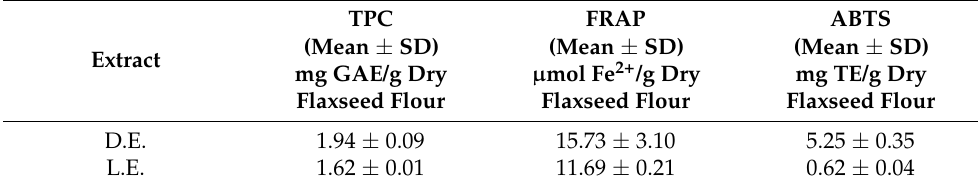
Table 2. Total phenolic content and antioxidant activity for D.E. and L.E.